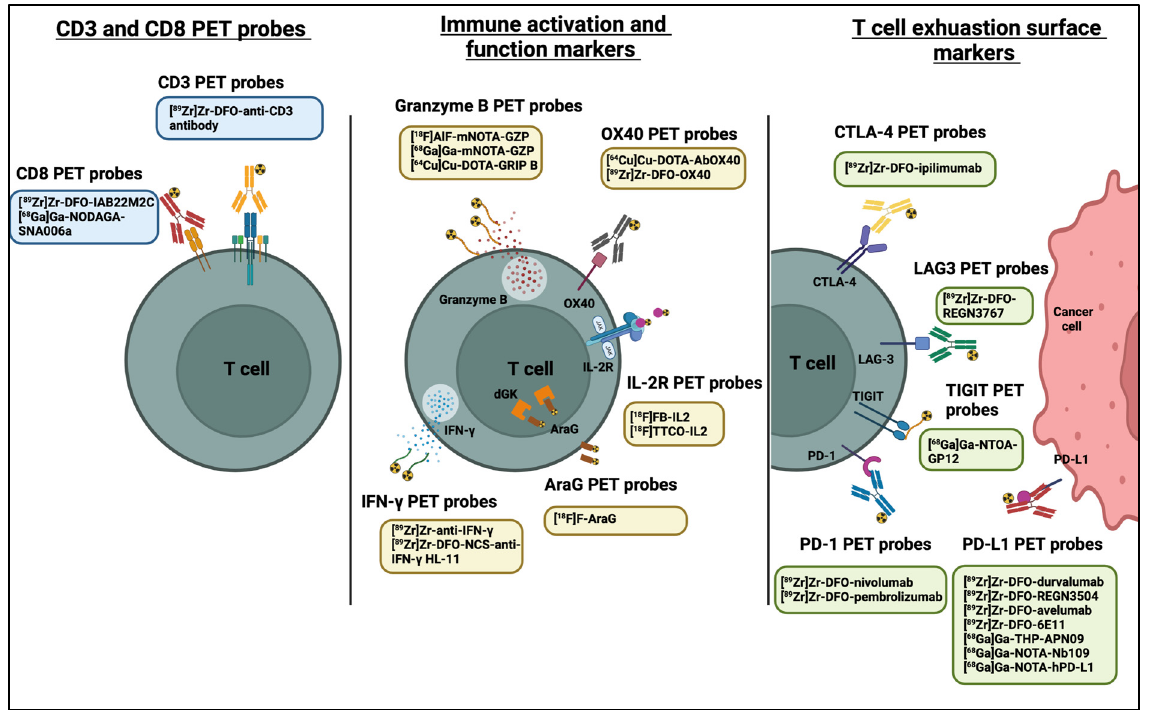
Figure 3. PET probes used in predicting and evaluating immune response to anti-cancer immunotherapy. Diagram was created with BioRender.com (accessed on 28 July 2022).